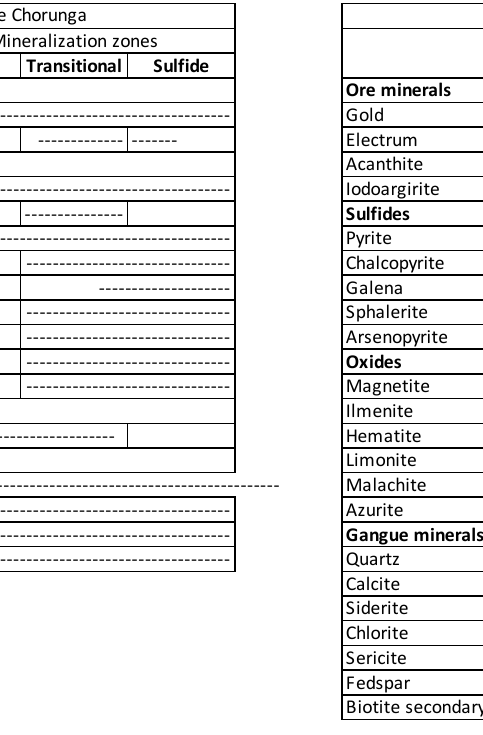
Figure 10. Paragenetic ore and gangue mineral associations from Mollehuaca and San Juan de Chorunga vein systems.